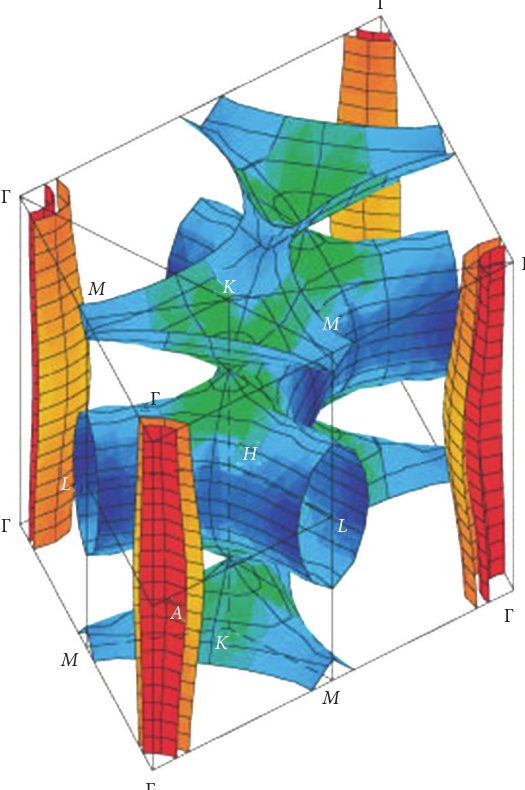
Figure 2: (From [8]) Calculated Fermi surface of MgB 2 , composed of four distinctive sheets. The σ sheets from the x , y orbitals of B are shown in red/orange (gap value ∼ 7.1 meV), whereas the π sheets from the z orbitals of B are shown in blue/gree (gap value ∼ 2.2 meV). c (cid:2) Nature publishing